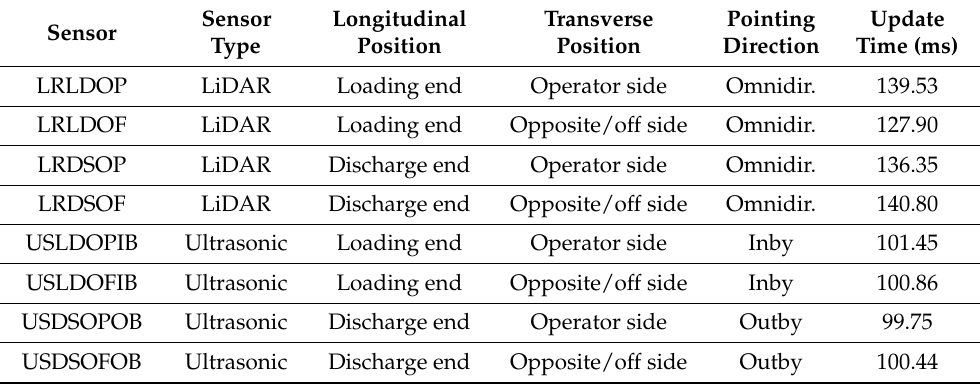
Table 6. Effective update rates of onboard sensors (calculated on the database